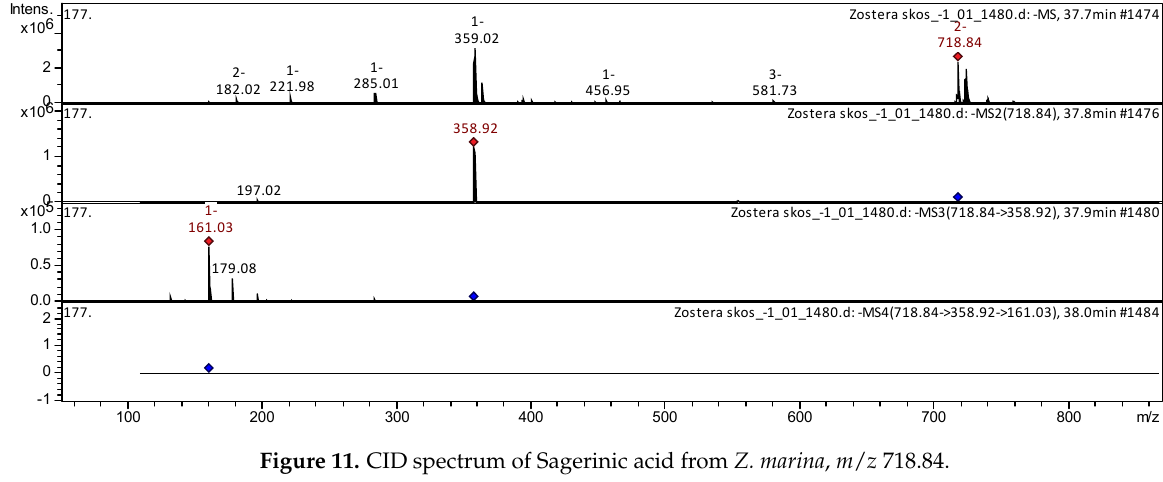
guisorba officinalis [20]; Actinidia chinensis [21]. Figure 11. CID spectrum of Sagerinic acid from Z. marina , m / z 718.84. Figure 11. CID spectrum of Sagerinic acid from Z. marina , m/z 718.84.